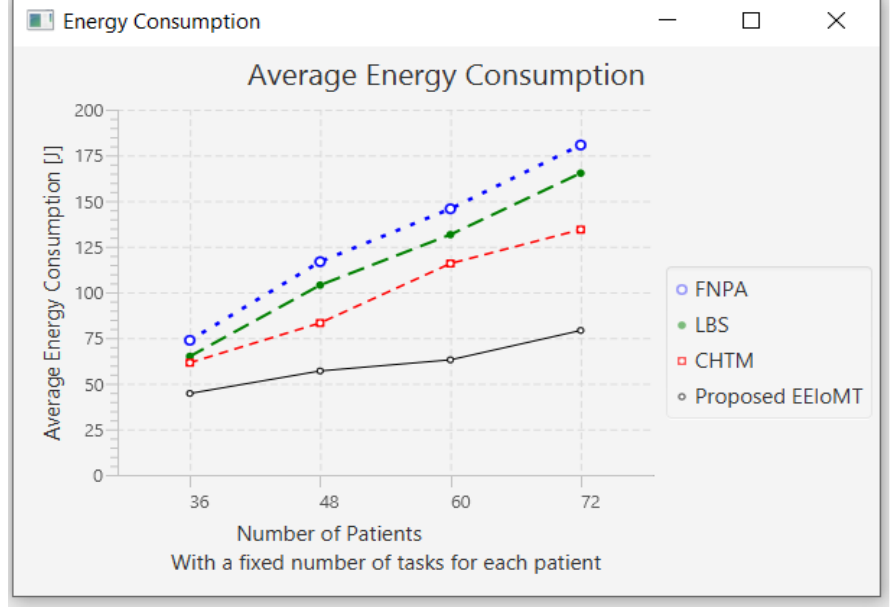
Figure 9. Average energy consumption comparison when changing the number of patients.